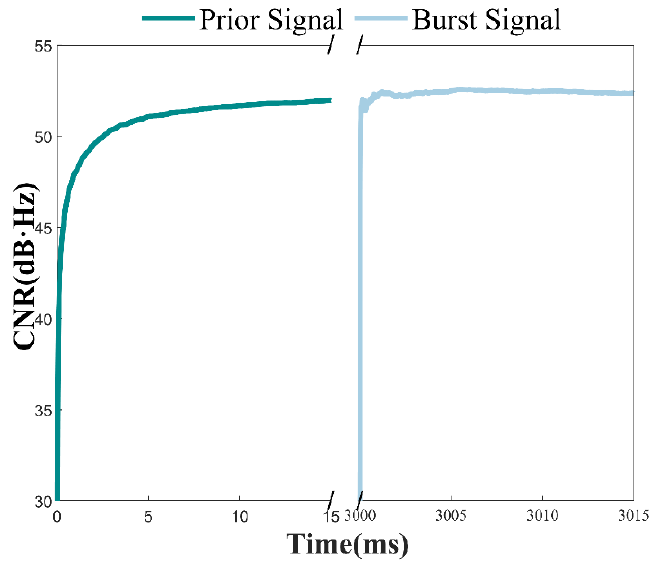
Figure 10. The estimated CNR of the robust anti-jamming